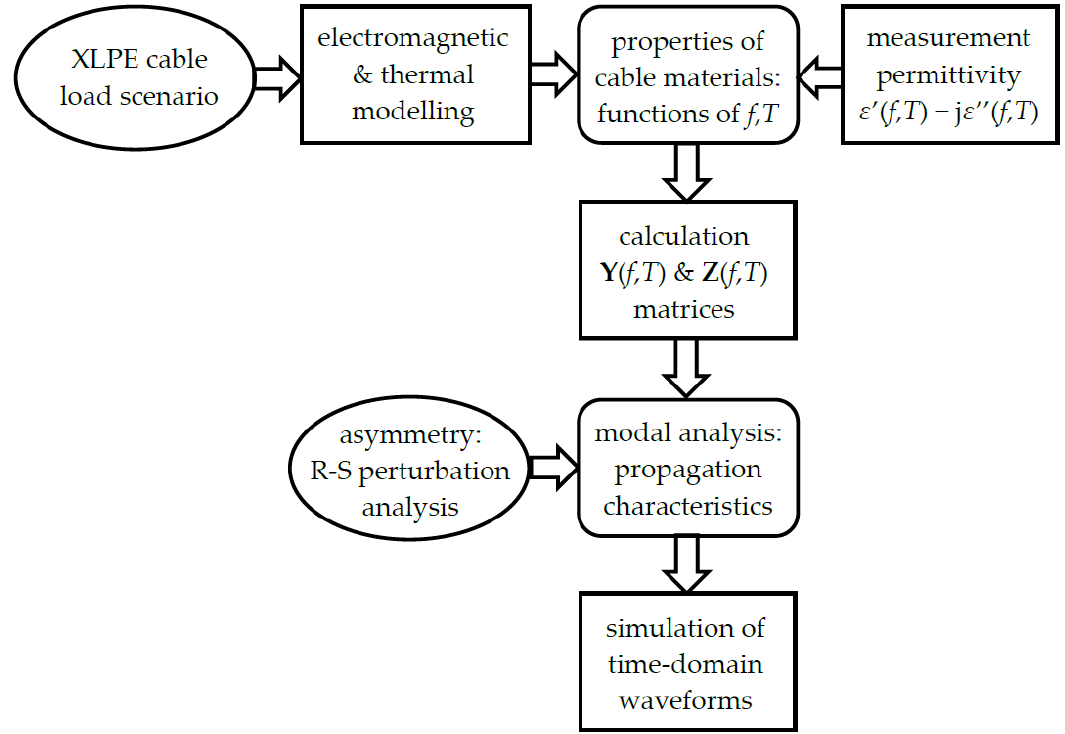
Figure 3. Scheme for modeling the time-domain response during cable loading. Table 2. Dimensions of a three-phase medium-voltage XLPE cable.